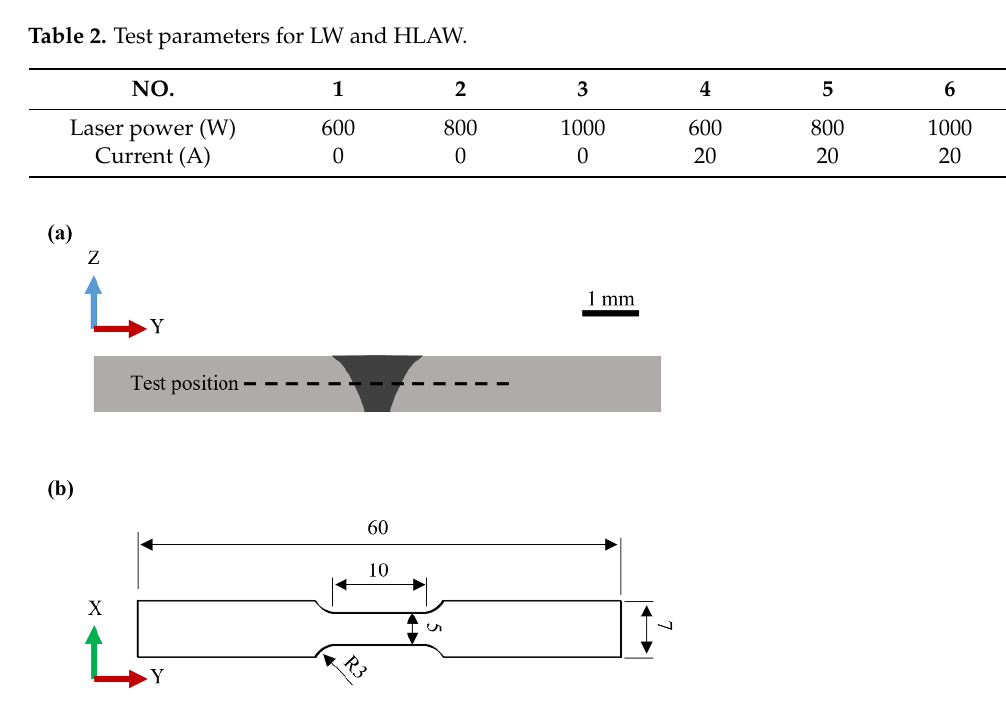
Figure 2. Microhardness test position and tensile size: ( a ) microhardness test position; ( b ) size of tensile (in mm).